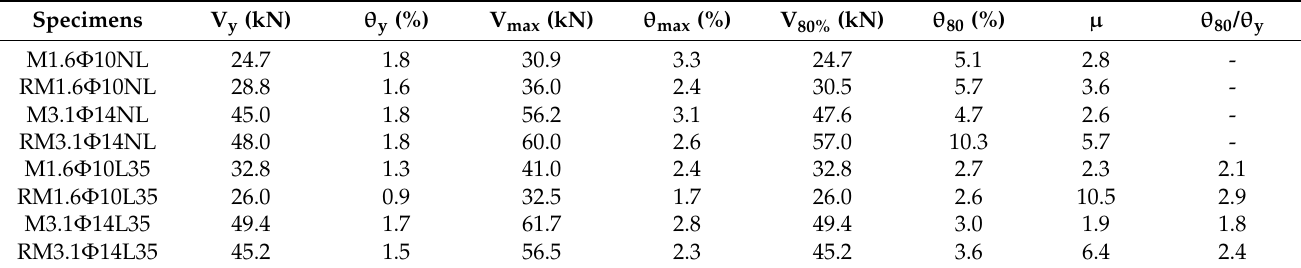
Table 5. Characteristic points of the retrofitted envelope curves and ductility µ